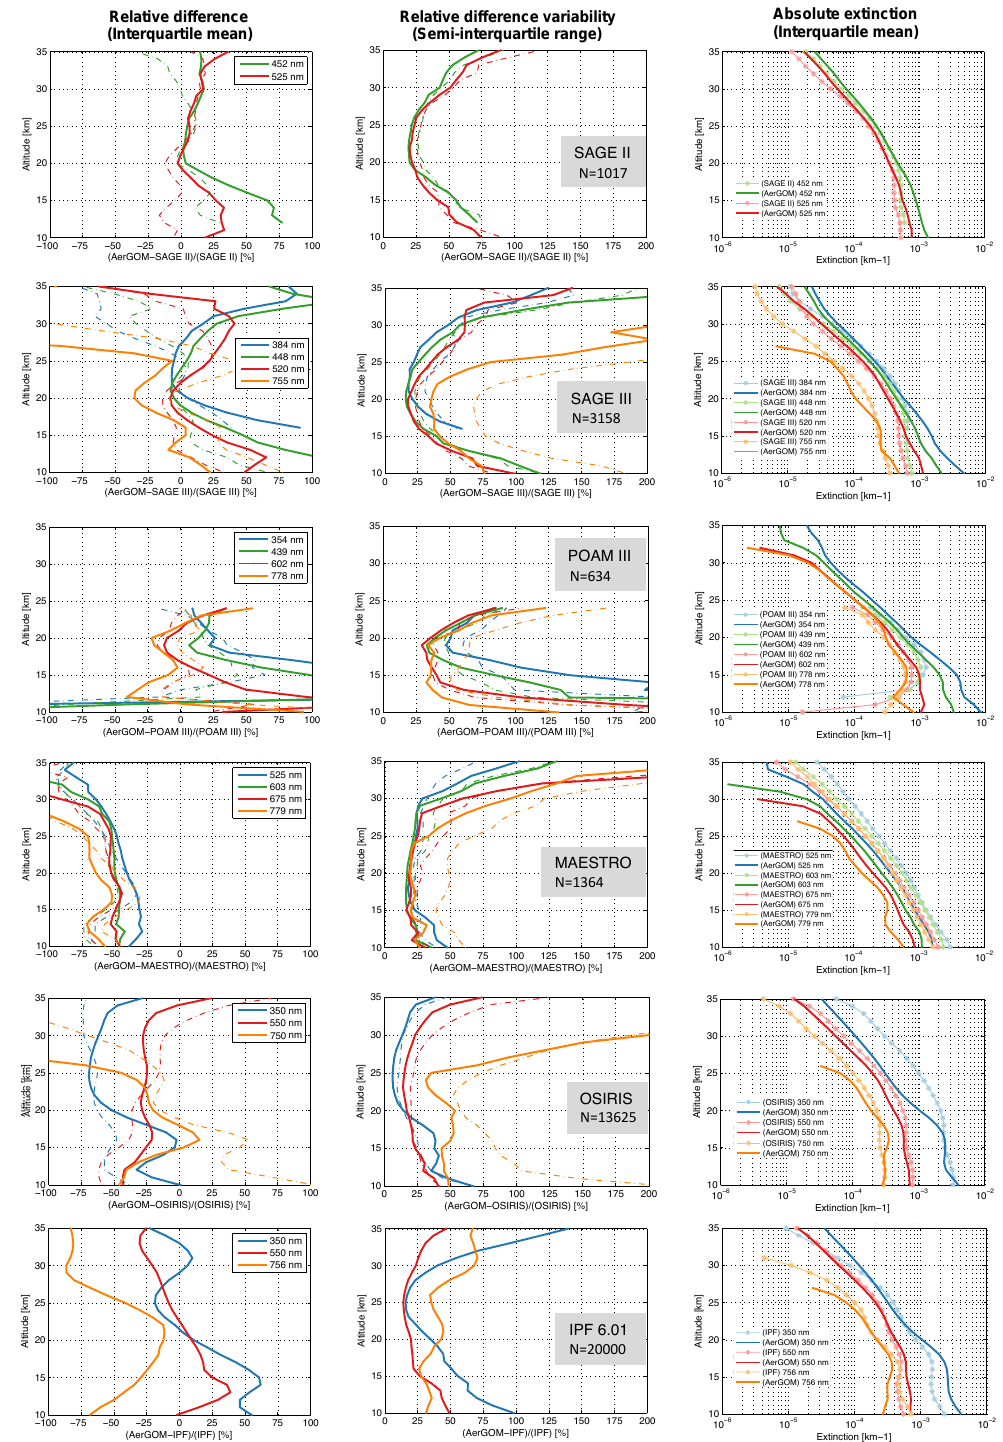
Figure 3. Relative difference (left panels), variability of the relative difference (central panels) and absolute aerosol extinction vertical profiles (right panels) for each dataset (SAGE II, SAGE III, POAM III, MAESTRO, OSIRIS and IPF) at various wavelengths compared with collocated AerGOM profiles. The dashed curves in the relative difference plots were calculated using IPF v6.01 instead of AerGOM. The total number of collocated profiles N is also